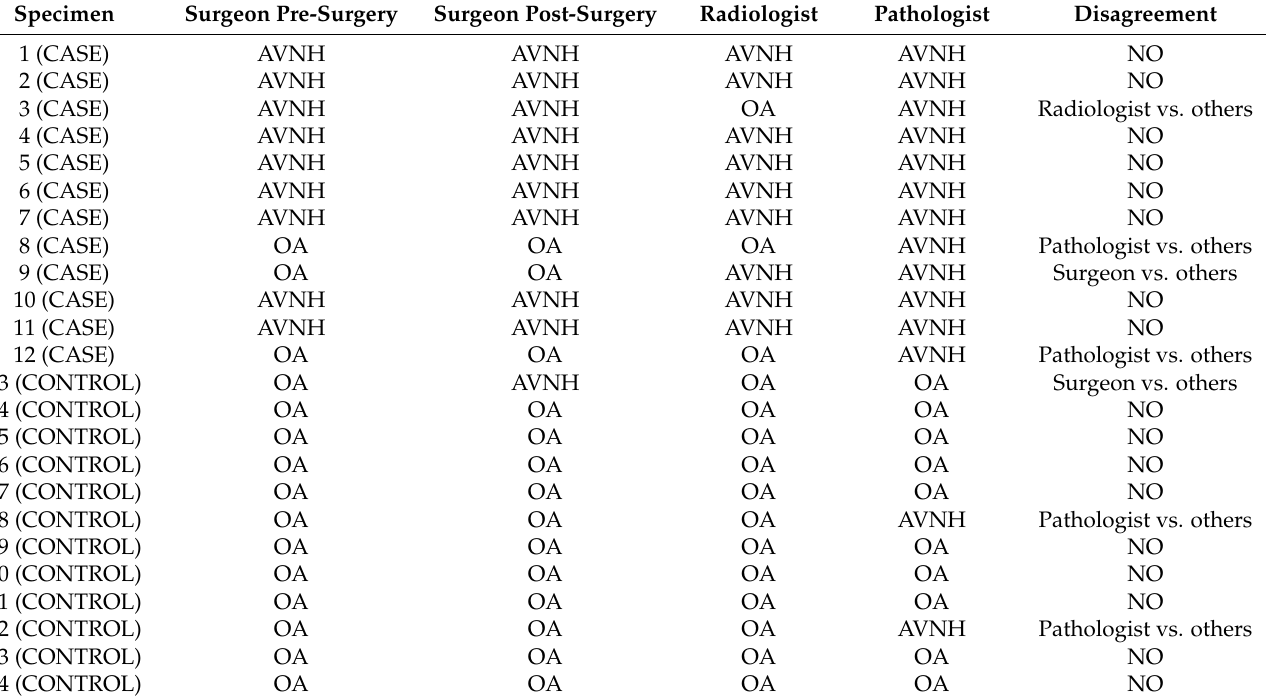
Table 1. From the initial sixty femoral heads collected, only twenty-four met our selection criteria, twelve with a previous diagnosis of ONFH and twelve controls with an OA diagnosis. The table illustrates the diagnosis of every sample according to different specialists: orthopedic surgeons, radiologists, and